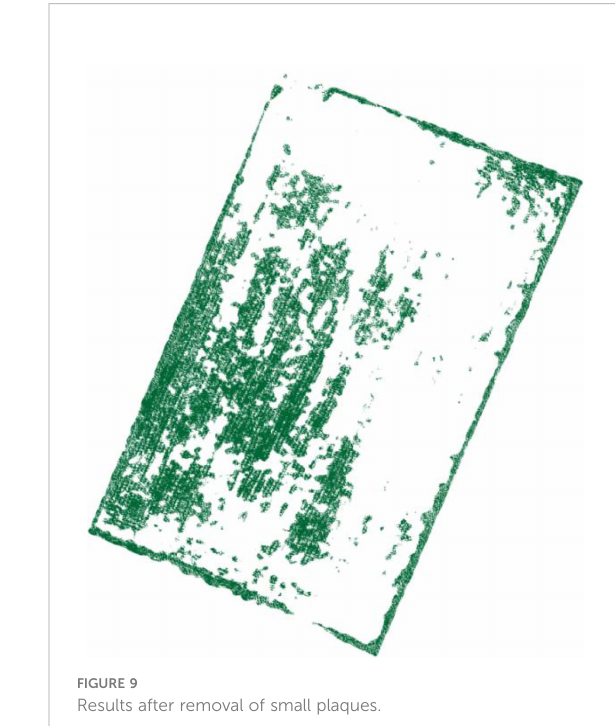
FIGURE 9 Results after removal of small